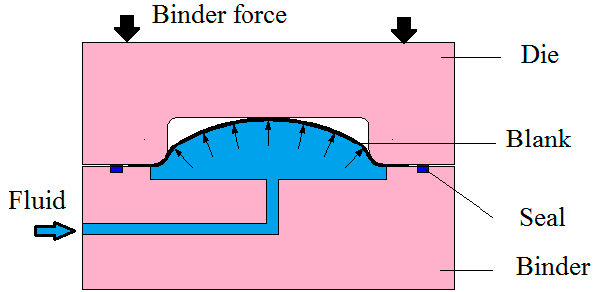
Figure 1. Hydrostatic formation process diagram.